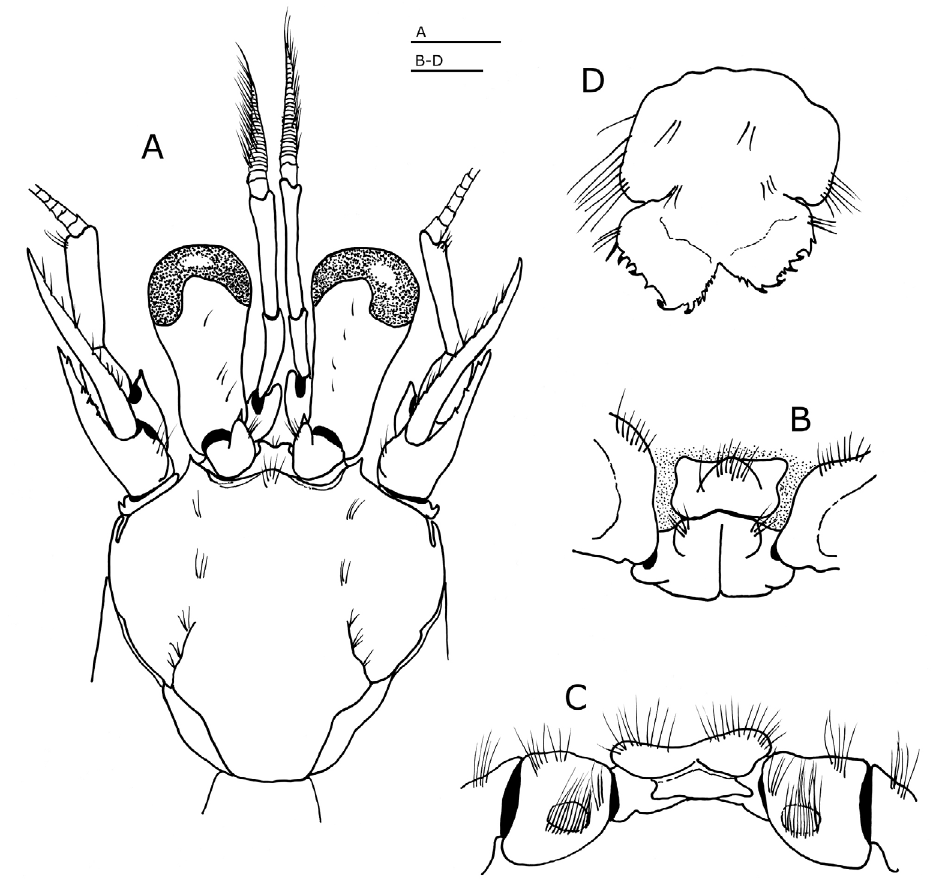
Figure 1. Pagurus politus (Smith, 1882), male lectotype 7.9 mm, USFC Albatross, sta 2823, northwestern Atlantic, Martha’s Vineyard, Massachusetts (USNM 16716): A , shield and cephalic appendages, dorsal view; B , anterior and posterior lobes of sternite XI (between third pair of pereopods), ventral view; C , sternite XIII (between fifth pair of pereopods), ventral view; D , telson, dorsal view. Scales = 3 mm (A), and 2 mm